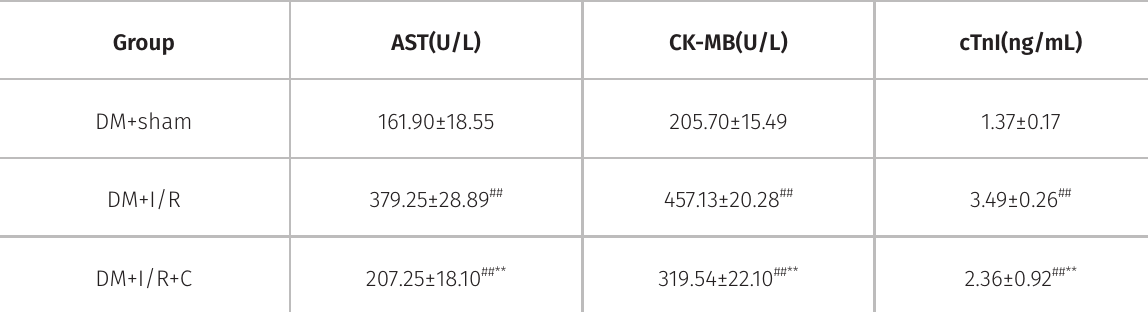
Table I. Assay of cardiac marker enzymes. Group AST(U/L) CK-MB(U/L) cTnI(ng/mL) DM+sham 161.90±18.55